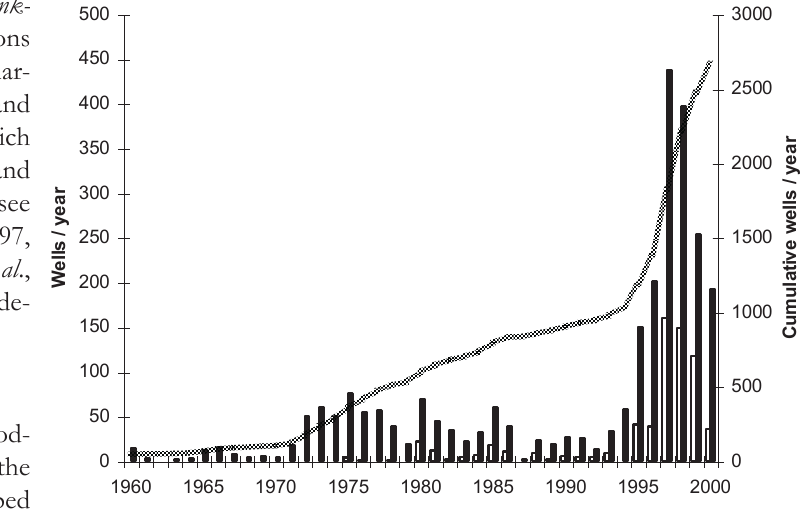
Fig. 2. The number of wells drilled in the WSAR study area from 1960 to 2000. Both the number of heavy oil and the total number of wells (conventional and heavy oil) drilled in each year are shown (bars), as is the cumulative number of wells drilled per year from 1960 to 2000 (smoothed line). Note increase in wells drilled 1995 and